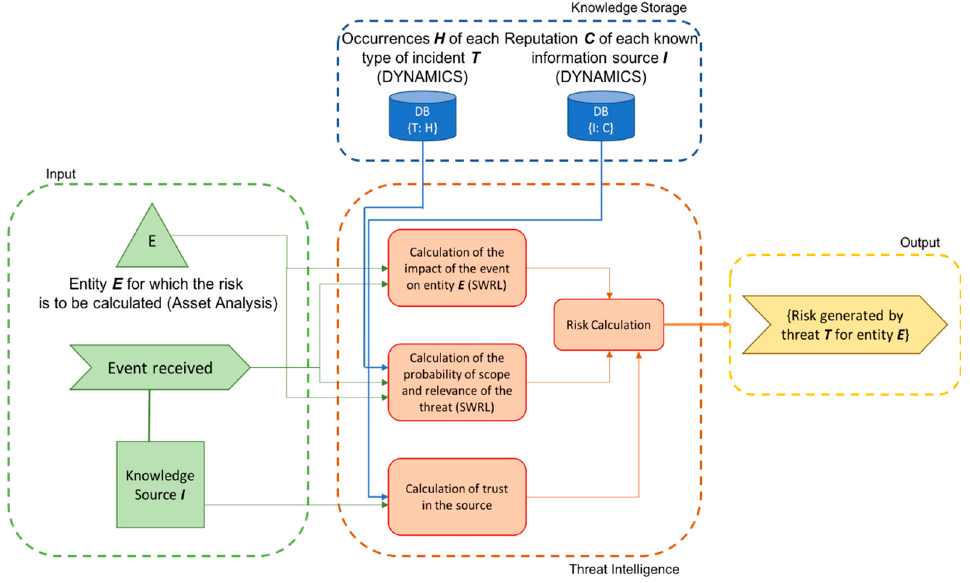
Figure 3. Overview of the architecture proposed.